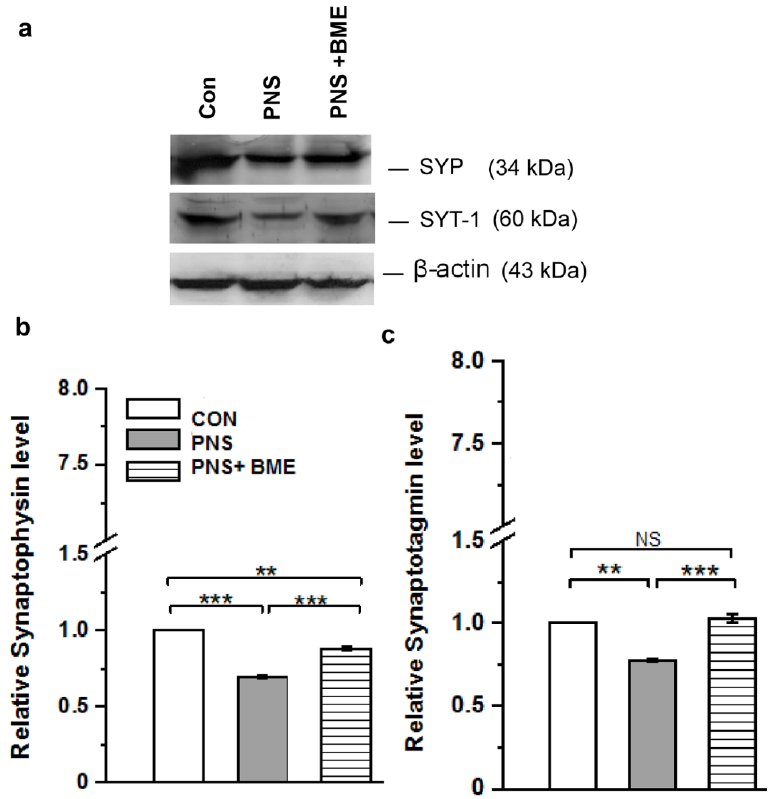
Figure 7. Exposure to BME treatment protects against PNS-induced changes in synaptic proteins. ( a ) Representative Western blots showing that the level synaptophysin (SYP) and synaptotagmin-1 (SYT-1) in the experimental groups; ( b ) SYP and ( c ) SYT-1 were significantly increased in the BME supplemented group. Data are expressed as mean ± SEM ( n = 6/each group). One-way ANOVA followed by Bonferroni post hoc test (for all pairwise multiple comparisons, statistical significance is indicated by ** p < 0.01 and *** p < 0.001; NS—Not significant).